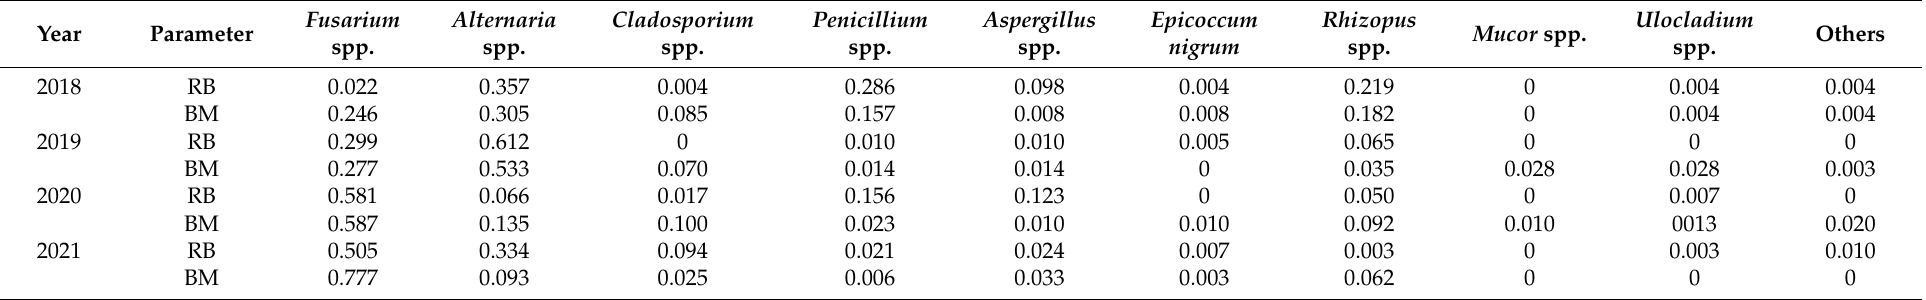
Table 2. Relative abundance of the 9 dominant fungal genera isolated from the respective 100 kernels of raw barley (RB) and corresponding barley malt (BM) of the 2018–2021 harvest years; number of different samples = 48.